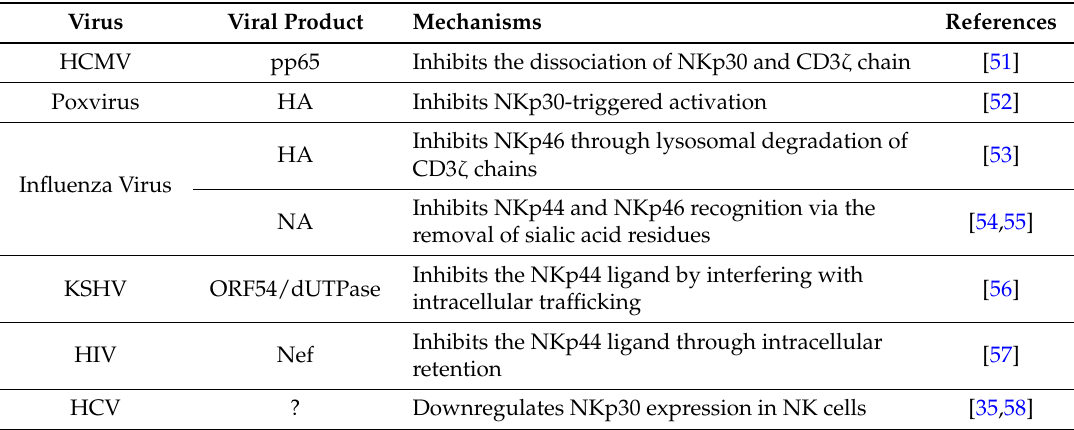
Table 2. Viral gene products and NCR-mediated evasion of NK cell